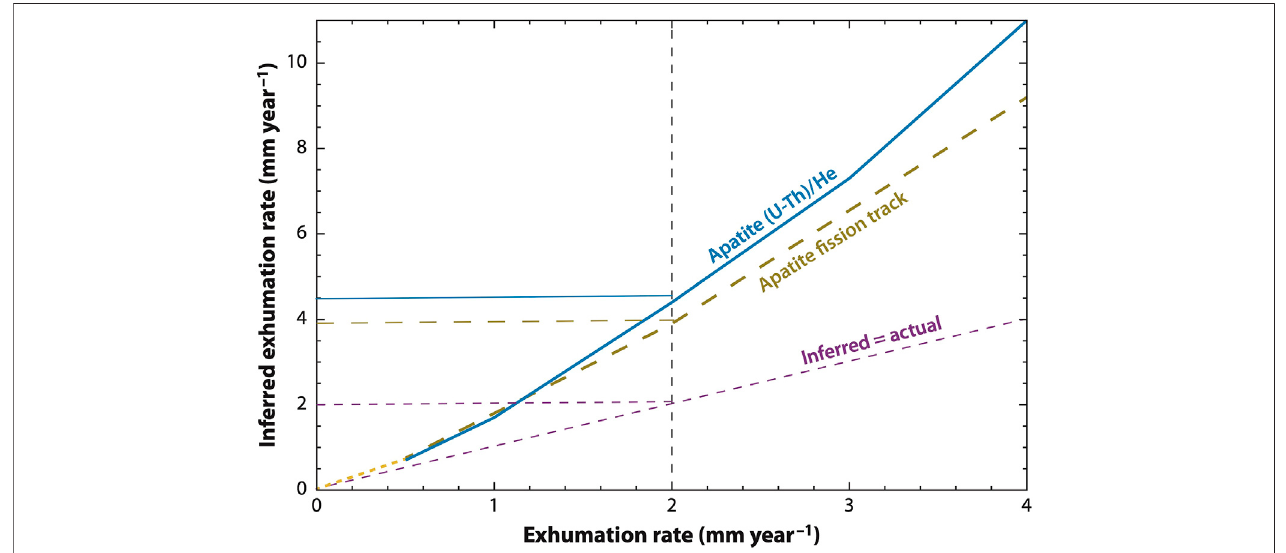
FIGURE 5 | Inferred vs actual exhumation rates for models of simple exhumation. Models assumed a 25 ° C/km initial geotherm, 5 ° C surface temperature, and a 60 ° C closure T for Apatite (U-Th)/He and 120 ° C for Apatite Fission Track (Note: we also calculated the Apatite Fission Track results using a kinetic model of track annealing and got the same results.) At exhumation rates of 2 mm/yr (2 km/Ma), rates inferred using apparent age and an assumed geotherm will be approximately a factor of two greater than actual exhumation rates.